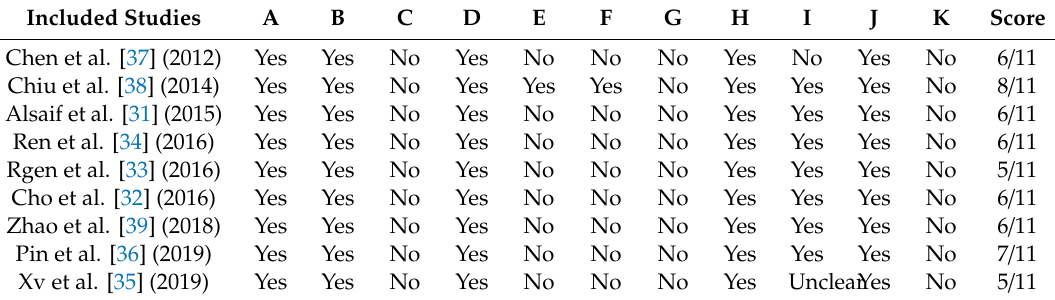
Table 2. Methodological Quality Assessment for Included